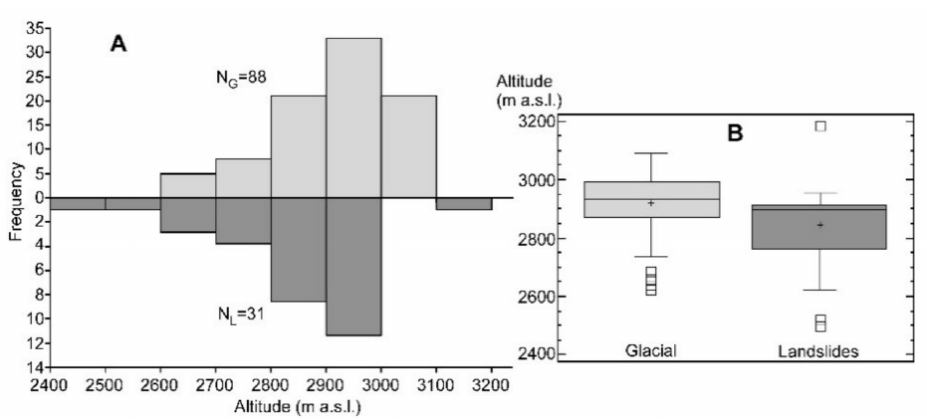
Figure 9. Statistical distribution of water-bodies formed by glacial and landslide processes in Sierra Nevada: ( A ) histogram showing the distribution of both formation models by altitude and ( B ) box-and-whisker plot showing differences of each formation model. N = number of